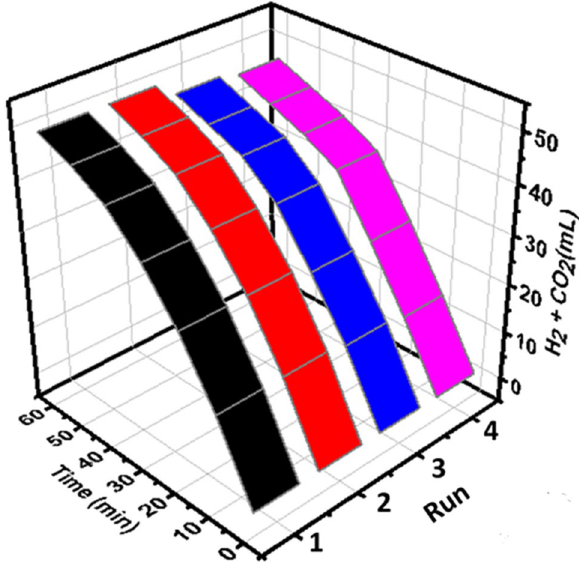
Figure 13. The recycling capability of Ag 1 Pd 1 /SLCN below visible light irradiation.